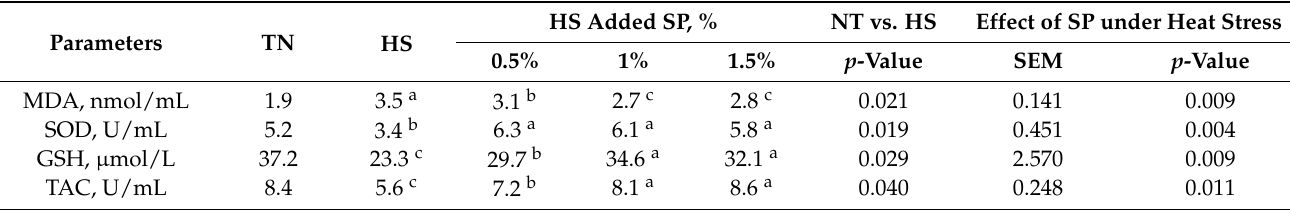
Table 5. Effect of dietary Spirulina platensis supplementation at different levels on blood redox profile of broiler chickens subjected to cyclic heat stress starting from 22 to 42 days of